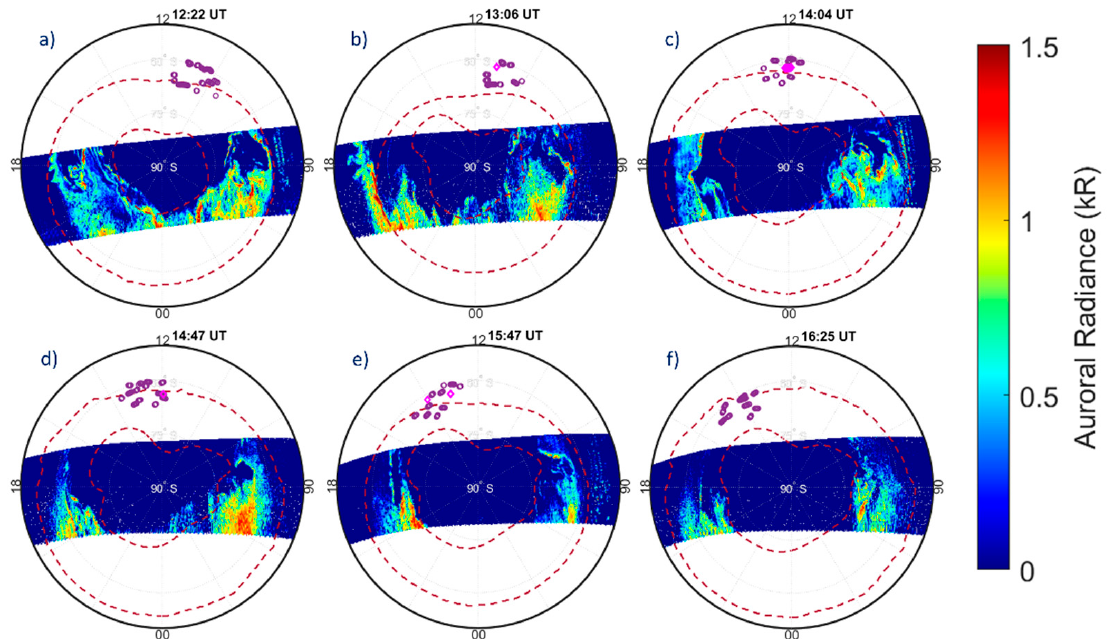
Figure 4. Polar-view maps in AACGM latitude and MLT of the austral auroral radiance as measured by SSUSI instrument in the LBHL band at 12:22 UT ( a ), 13:06 UT ( b ), 14:04 UT ( c ), 14:47 UT ( d ), 15:47 UT ( e ) and 16:25 UT ( f ) on 8 September 2017. Each map also reports the auroral oval boundary location (red dashed contours), as retrieved from the auroral radiance data, the amplitude scintillations greater than 0.1 ( S 4 , magenta diamonds), recorded at SANAE IV base during the DMSP passage, and all the σ ϕ values having elevation angle α = 30 ◦ (purple circles). Scintillation data were projected to 350 km altitude. Each map covers 00:00–24:00 MLT and |50 ◦ |–|90 ◦ | AACGM Lat, the magnetic noon/midnight is at the